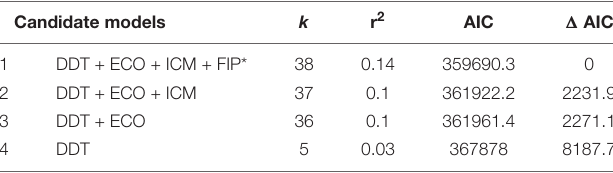
DDT, Dominant disturbance type; ECO, Ecoprovince; ICM, Initial live tree C measurement; FIP, Federal Information Processing System state/county code. *Indicates variable included as a random effect.